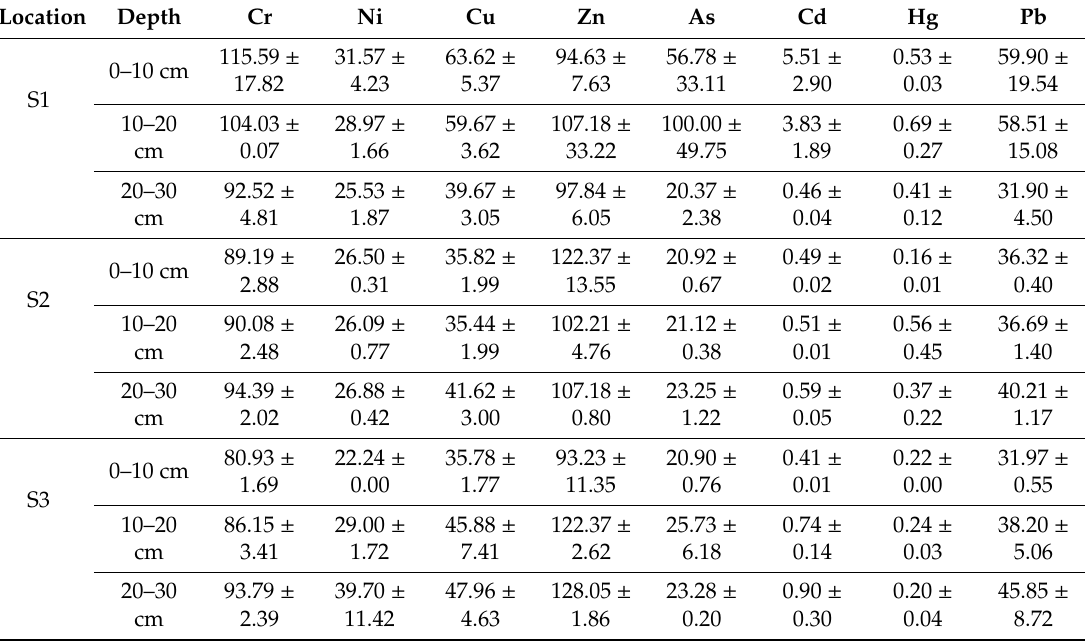
Table 3. Mangrove soil-borne trace elements (mg / kg) in the upper intertidal zone.